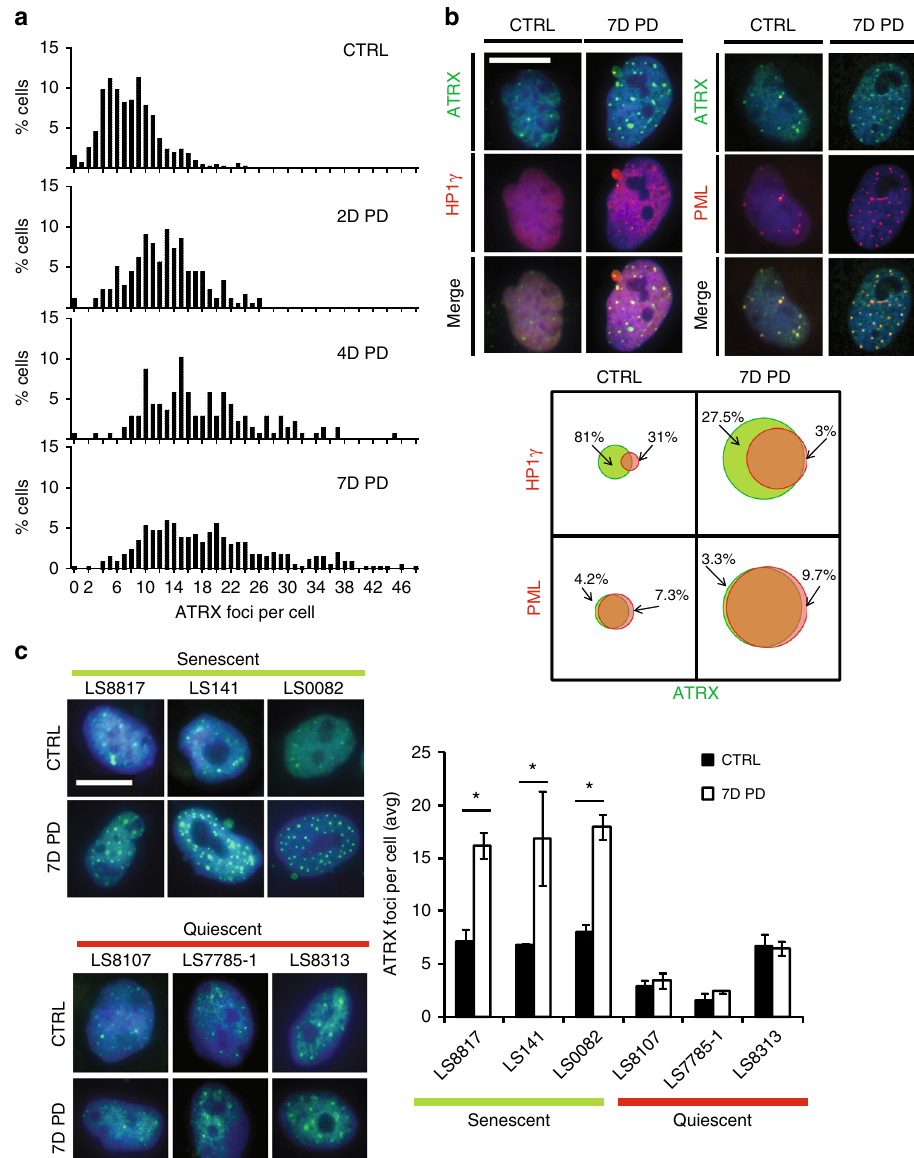
Fig. 2 ATRX accumulates in nuclear foci in senescent cells that colocalize with HP1 γ SAHF. a LS8817 cells were treated with PD0332991 for the indicated number of days, fi xed and subsequently stained with ATRX antibodies. The number of ATRX foci in each cell ( > 150 cells per graph) were counted and plotted. The percentage of cells with a number of foci is indicated on the y -axis. b LS8817 cells were treated with PD0332991 for 7 days and the co- localization of HP1 γ ( left ) or PML foci ( right ) with ATRX foci determined by immuno fl uorescence. Representative images are shown. The fraction of ATRX foci co-localized with either HP1 γ or PML foci was quanti fi ed in control and treated cells. Circles in the Venn diagrams are drawn to scale relative to the number of the indicated foci in each condition. c The indicated liposarcoma cell lines were treated with PD0332991 for 7 days as previously described 35 . The outcome of this treatment vis a vis quiescence or senescence is indicated. ATRX foci were detected by immuno fl uorescence and the average number of foci per cell is plotted ( right ). Representative images are shown on the left . All data are represented as mean ± SEM from at least 3 independent experiments. Asterisk indicates p < 0.05 using a two-sided Students t- test. All images were taken at the same magni fi cation. The scale bar is 20